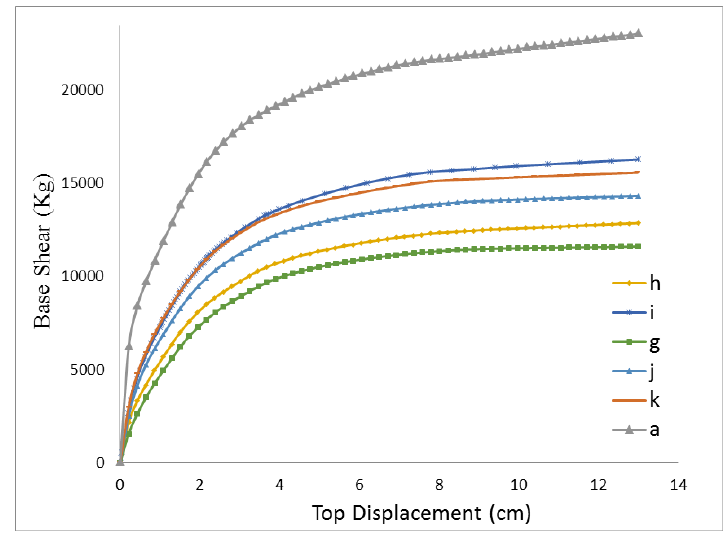
Figure 21. Load-displacement curves of specimens with different number of opening model (g–k).